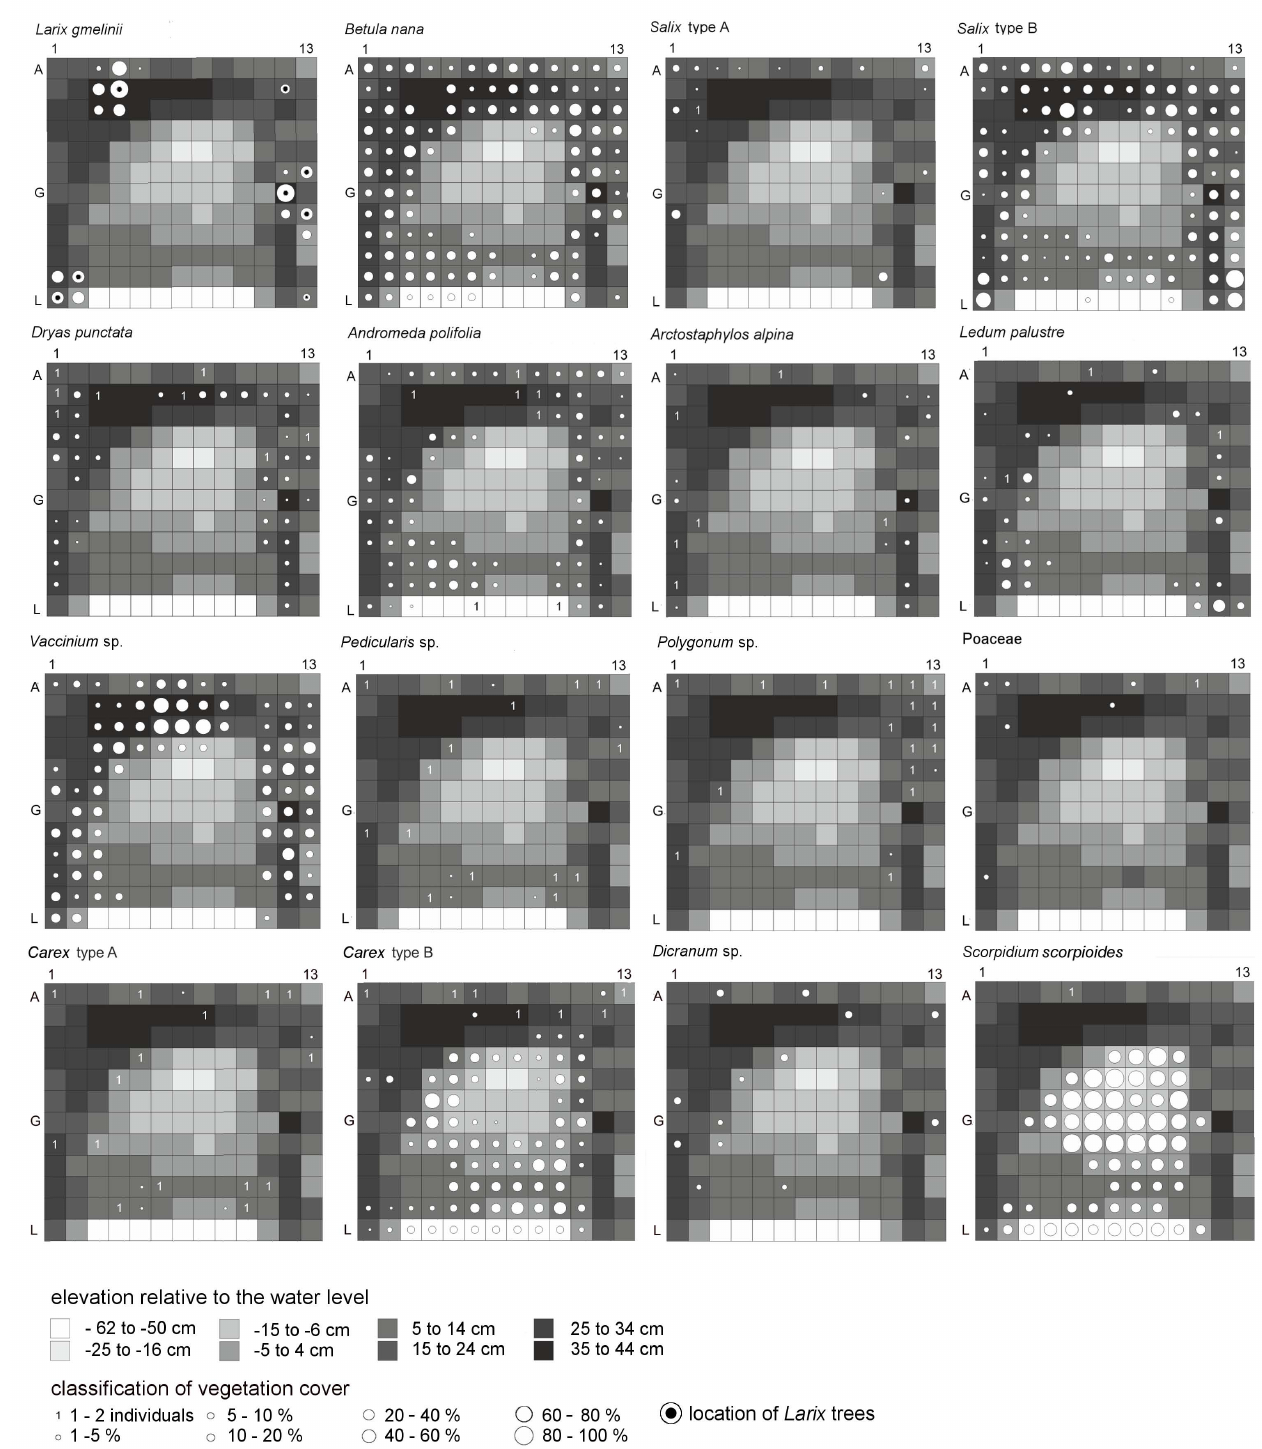
Fig. 3. Distribution of plant taxa, presented in vegetation abundance/cover classes (after Braun-Blanquet, 1964) represented by circles, and related to the elevation (in cm, relative to the water level in the pond). Double circles indicate the locations of Larix trees (after Wolter,